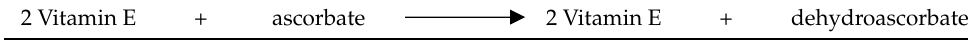
Table 1. The mechanism of the quenching of singlet oxygen by β -carotene. Table 3. The reaction of vitamin E radical with ascorbic acid. 1 O 2 + β -carotene O 2 + β -carotene * β -carotene * β -carotene + energy (heat) β -carotene * all- trans - β -carotene β -carotene * -triplet excited